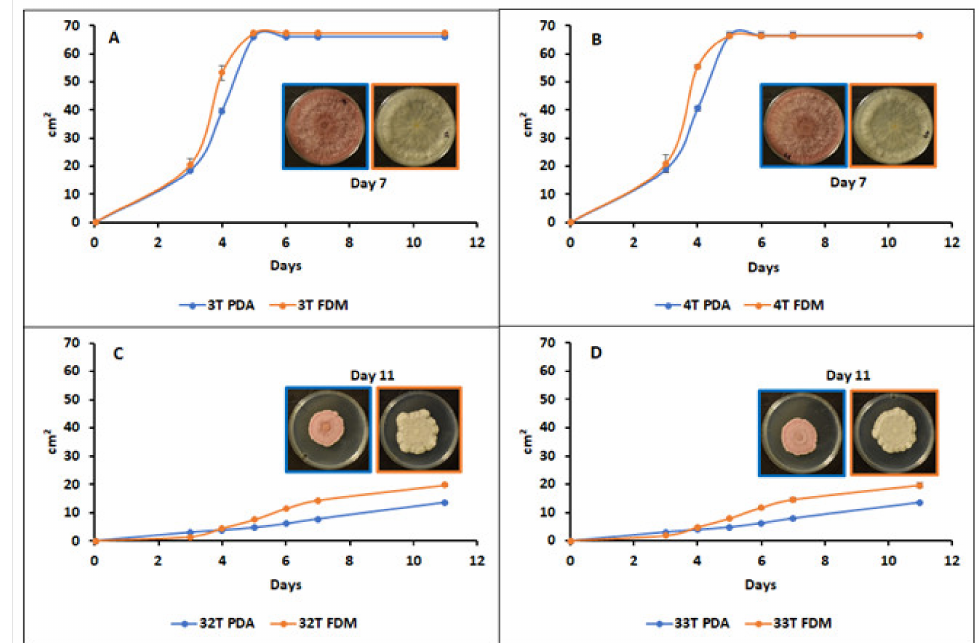
Figure 2. Growth kinetics and mycelial colony aspects of four isolated Fusarium strains (( A ) = 3T, ( B ) = 4T, ( C ) = 32T, and ( D ) = 33T) on PDA and FDM-agar media. Values are means of 3 replicates. Error bars are ± standard